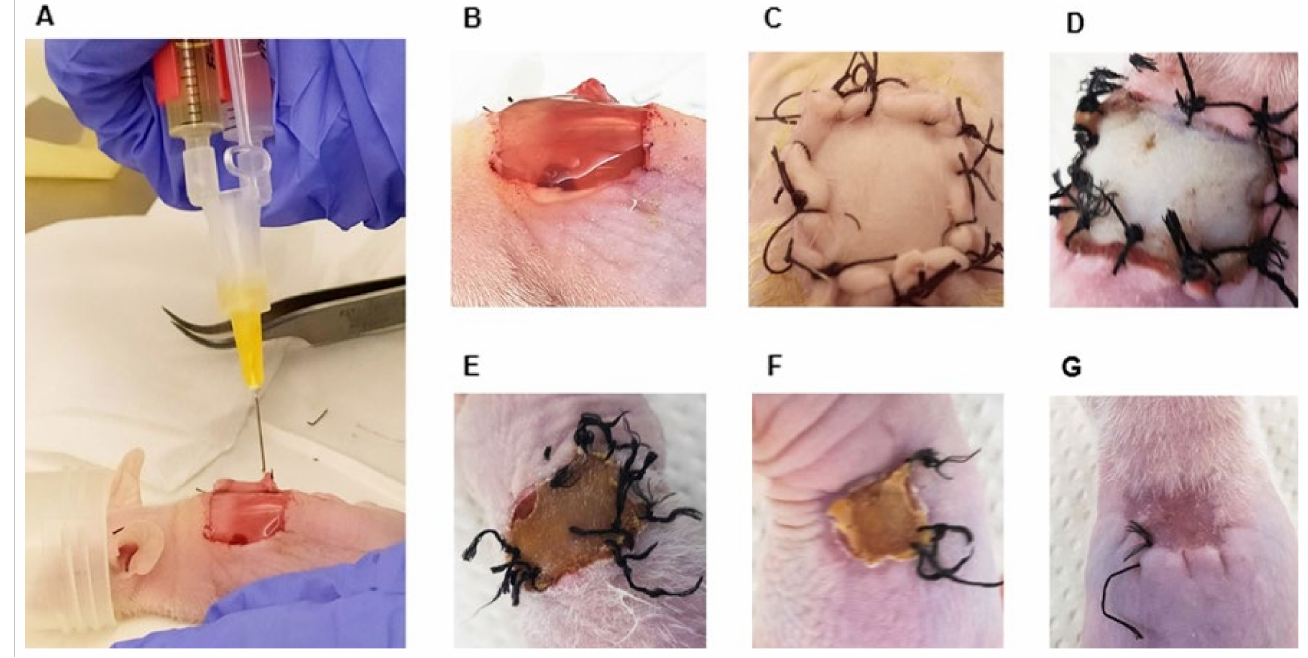
Figure 3. In vivo fabrication of polymerizable skin hydrogel. ( A ) In vivo extrusion of the polymeriz- able skin hydrogel. ( B ) Extruded hydrogel on the wound bed at room temperature remained stable without leaking. ( C ) Devitalized murine skin sutured to the dorsum of the mouse after surgery. ( D – F ) Wound healing follow-up. Devitalized skin shrank and detached gradually from the back of the mouse. ( G ) Regenerated human skin in the back of the athymic mouse. Wound completely healed after 21